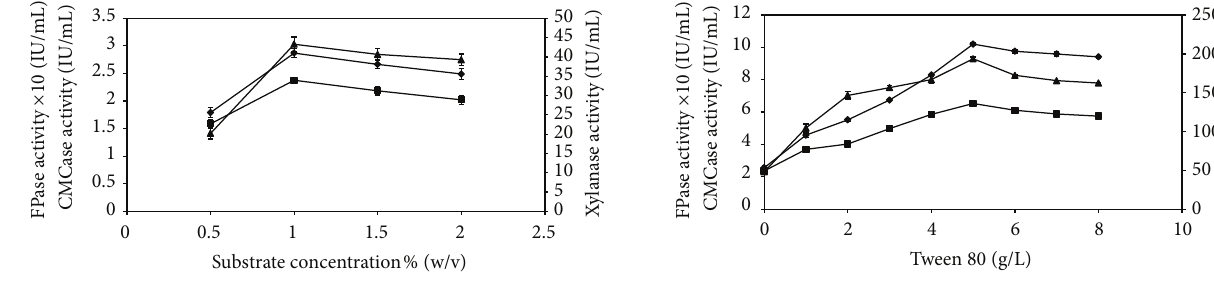
Figure 7: Effect of substrate concentration on CMCase, FPase, and xylanase activities. Results are presented as the mean of three replicates with standard deviation: ( Q ) FPase; ( ◼ ) CMCase; ( 󳵳 ) xylanase.